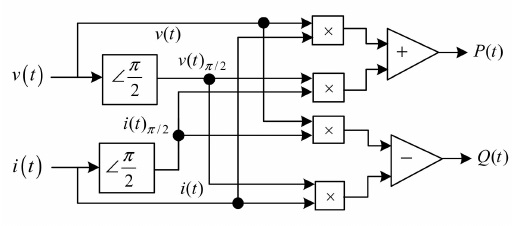
Figure 4. The fast power calculation block.